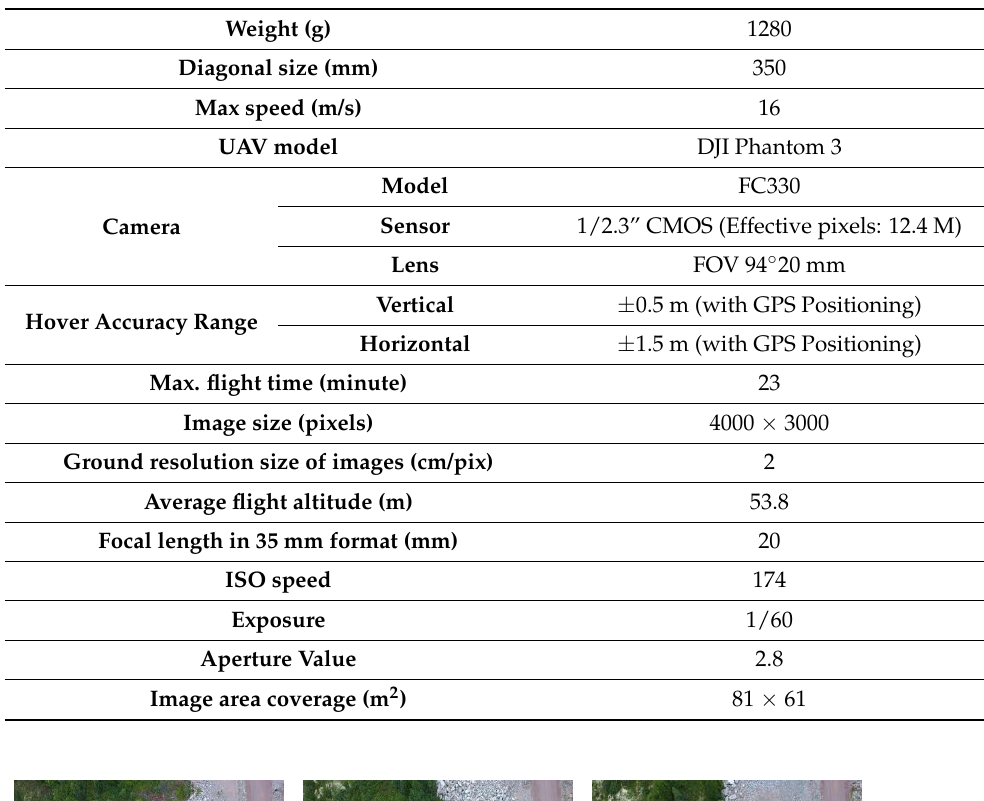
Table 2. The UAV image pair specifications.